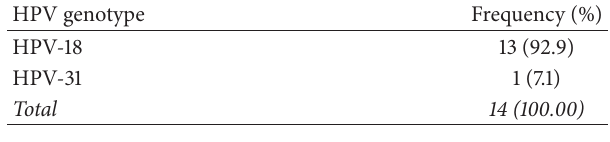
Table 4: Frequency of HPV genotypes.